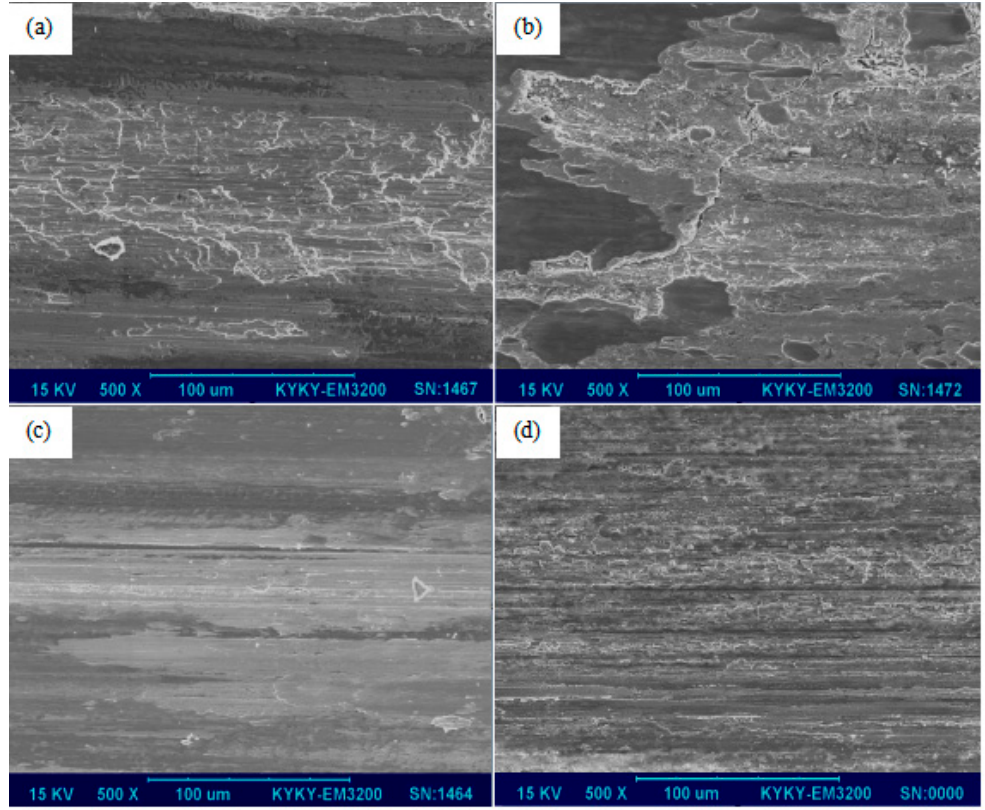
Figure 13. The wear surface morphology of cladding layer with different reinforcement phase contents and current-carrying. ( a ) 15%, 0A; ( b ) 15%, 20A; ( c ) 25%, 0A; ( d ) 25%, 20A.